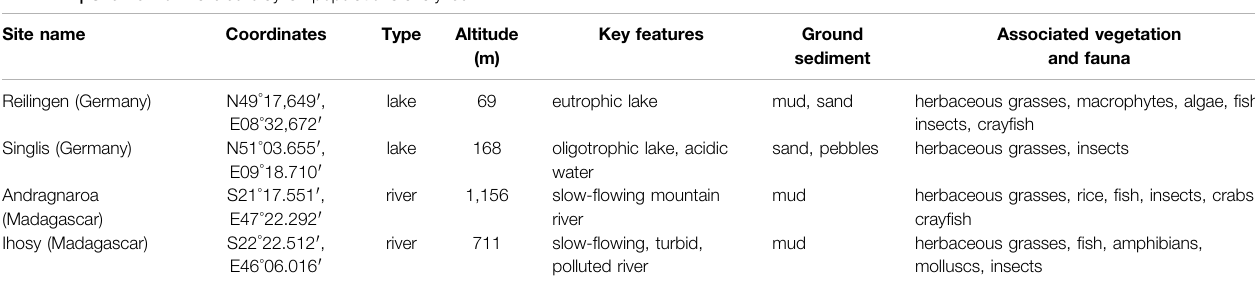
TABLE 1 | Overview of marbled cray fi sh populations